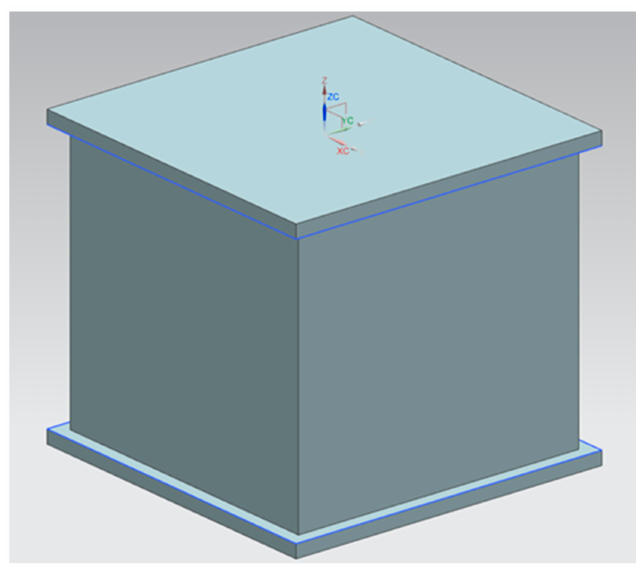
Figure 2. The 3D model of the chamber.